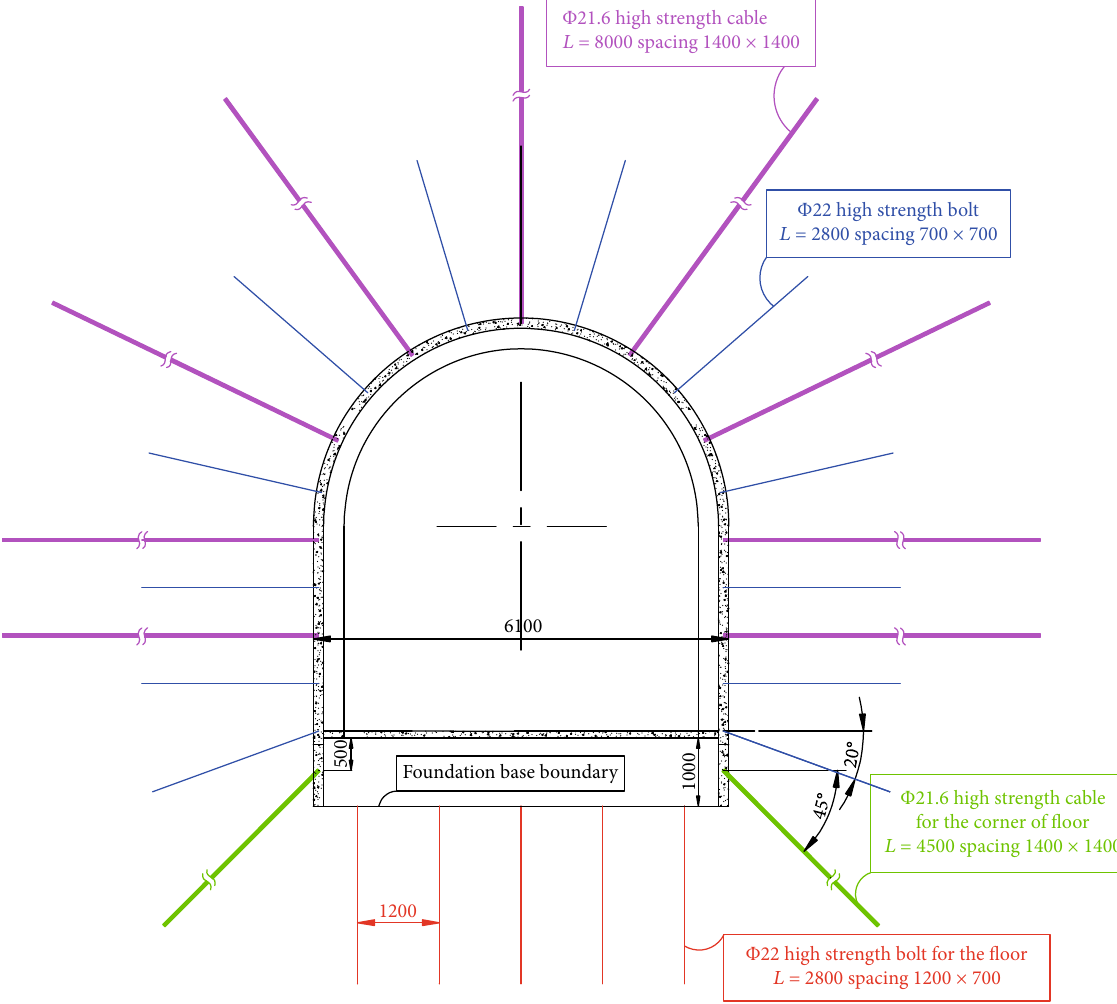
Figure 7: Full section support scheme after